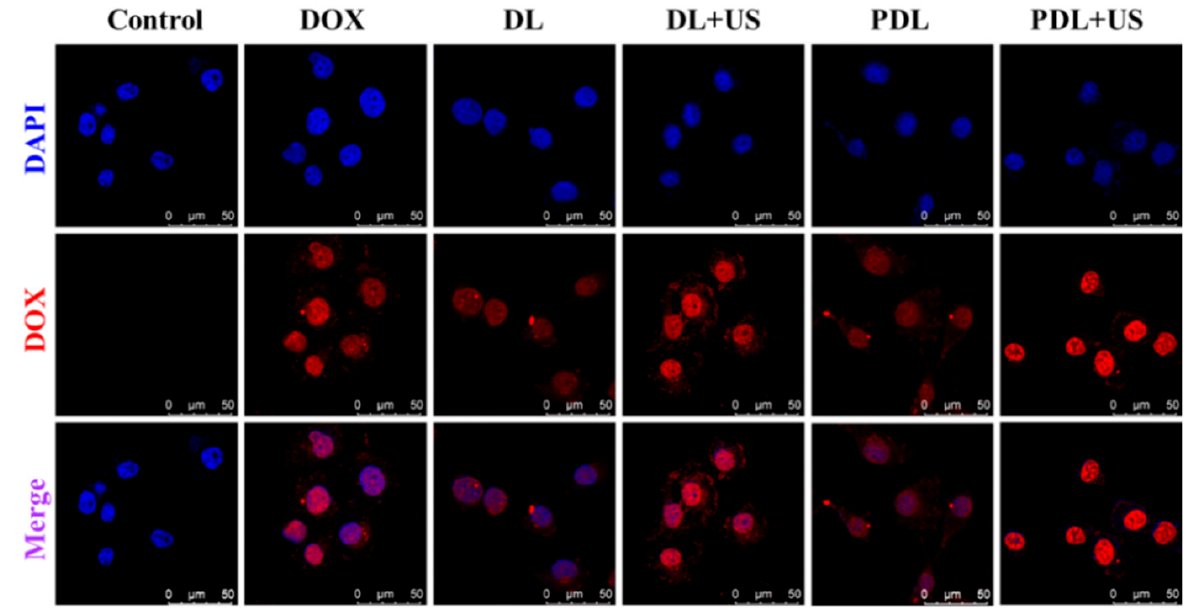
Figure 2. Laser confocal microscope observation of cell uptake of nanoparticles using the red fluorescence emission of DOX (Control: DMEM medium; DOX: free DOX; DL: DOX-liposomes; DL+US: DOX-liposomes + US irradiation; PDL: DOX-loaded Pp18-liposomes; PDL+US: DOX-loaded Pp18-liposomes + US irradiation; scale bar = 50 μ m).